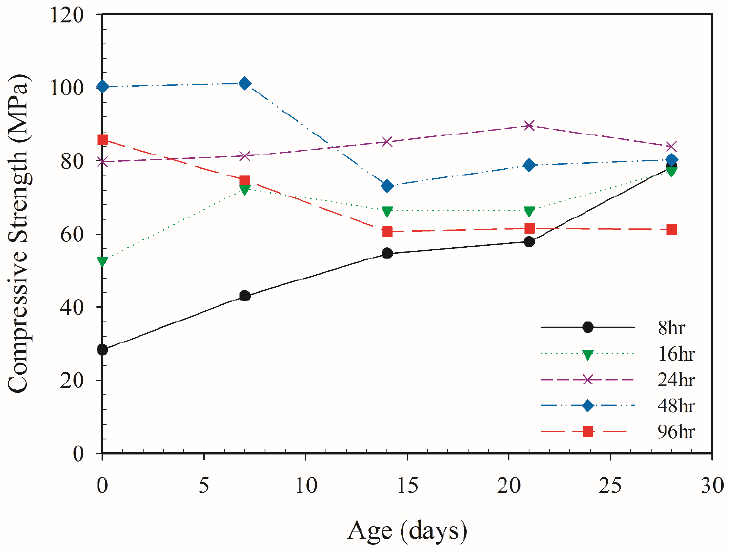
Figure 12. Changes in compressive strength with standing time in air under various curing durations of specimens cured at 70 °C when AE% = 6%.